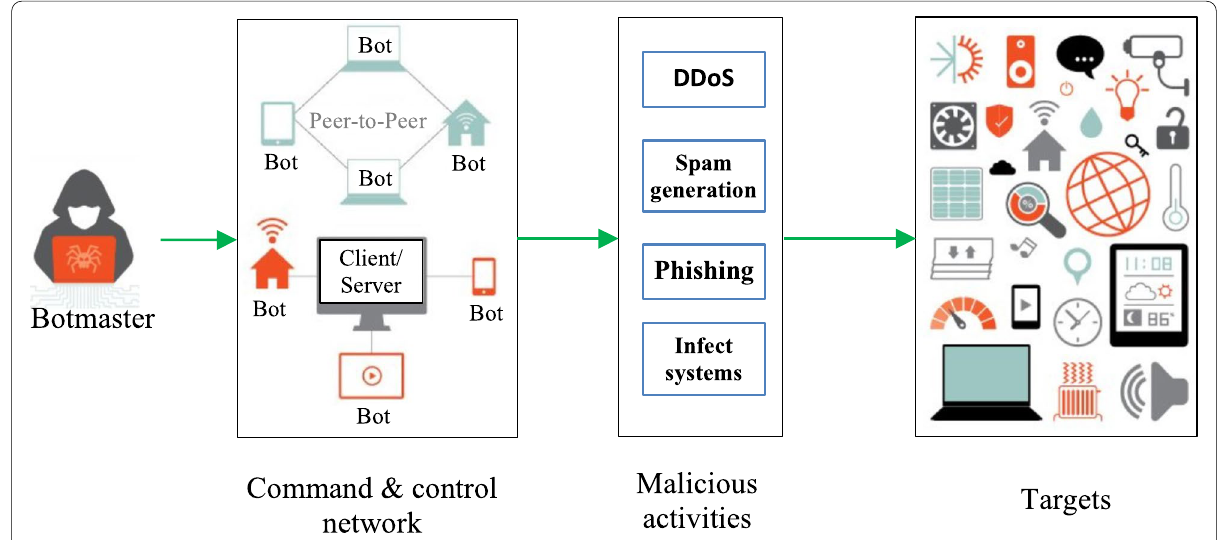
Fig. 3 The flow of Botnet attack from the Botmaster to the target devices across the command & control